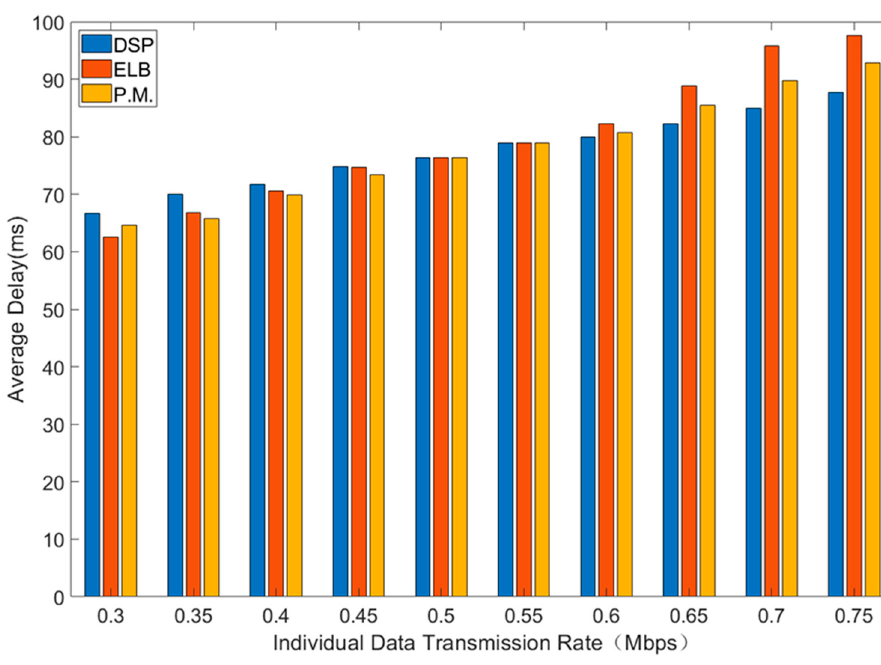
Figure 4. The average delay for different sending rates.